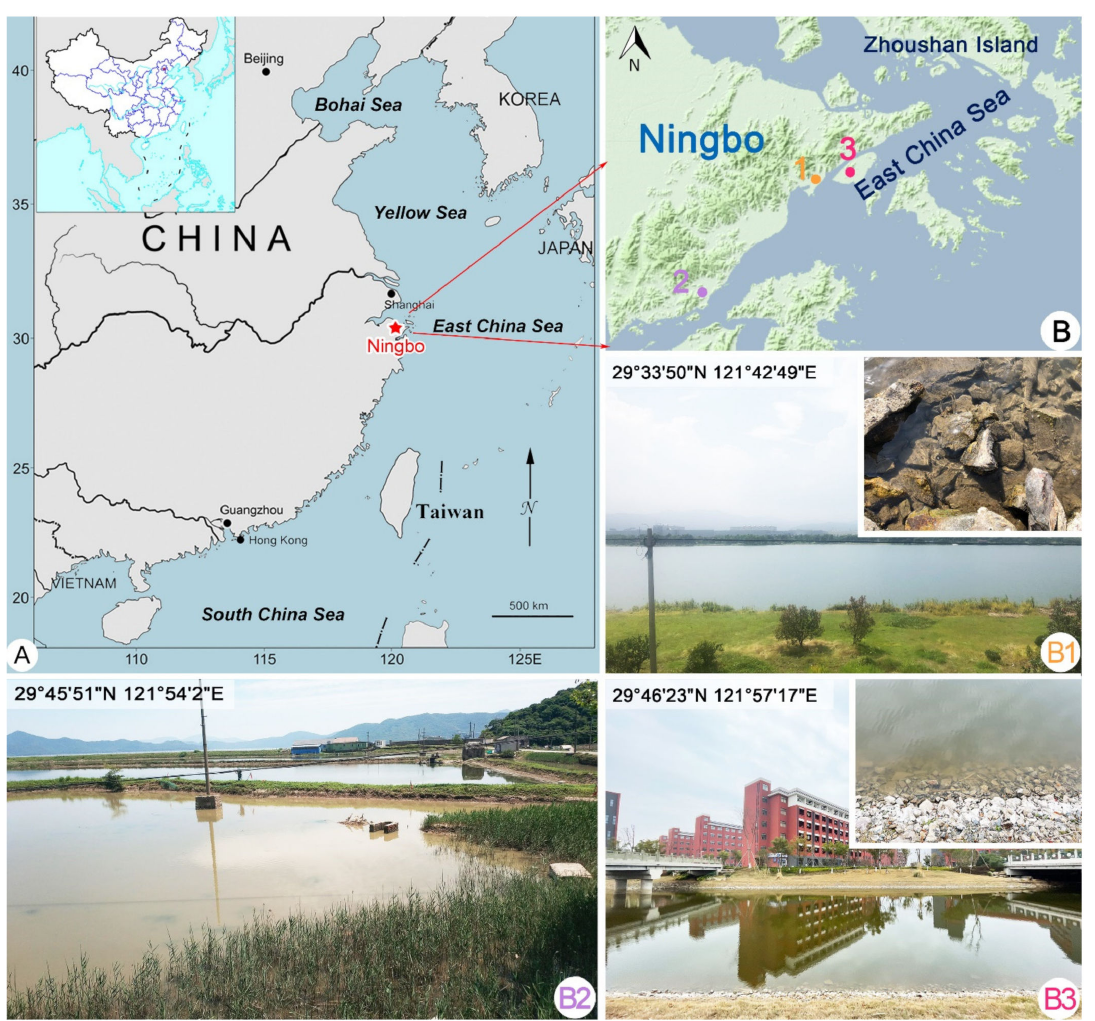
Figure 7. Maps showing the location of Ningbo and the sampling locations in Ningbo and pho- tographs of the sampling sites. ( A ) Map of China showing the location of Ningbo. ( B ) Portion of the map of China showing the location of sampling sites in Ningbo (colored circles and num- bers). ( B1 ) Sampling site for Dysteria brasiliensis (Ningbo populations II–V) and Dysteria crassipes . ( B2 ) Sampling site for Dysteria brasiliensis (Ningbo population-I). ( B3 ) Sampling site for Dysteria paracrassipes n.